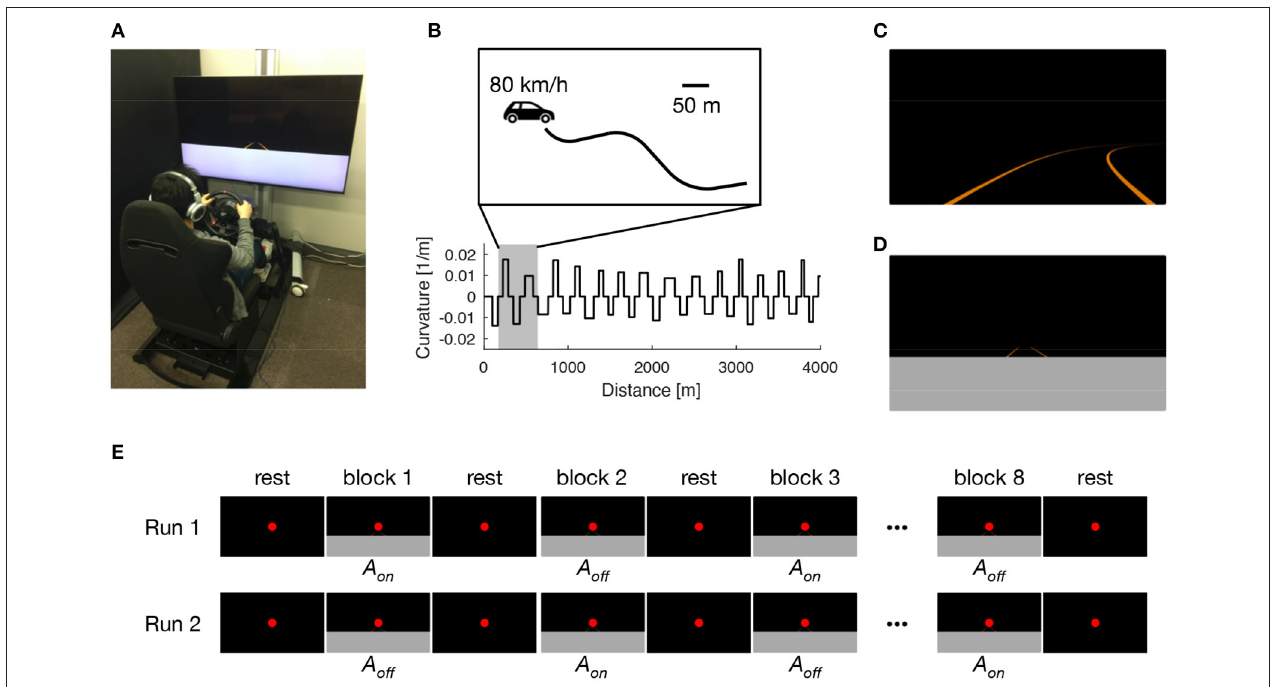
FIGURE 1 | Experimental setup. Participants performed 8 days of lane-keeping training on a custom-made driving simulator (A) . Driving courses consisted of a winding road that alternately curved leftward and rightward with a random curvature between 1/120 and 1/60 m − 1 , interleaved with straight sections with a constant length of 60 m (B) . Under normal driving (ND) condition, driving scenes were presented with auditory white noise with a constant loudness to both ears via headphones (C) . Under sensory augmentation (SA) condition, the lower part of the driving scene was occluded to restrict the visual cues needed for estimating vehicle lateral position, and information regarding vehicle lateral position was instead provided via binaural auditory stimuli (D) . The pretest and posttest MRI sessions comprised two block-design runs, in which participants were exposed to sensory stimuli that were relevant to the lane-keeping task under SA condition. In each run, driving scenes were presented alternately with ( A on ) and without ( A off ) auditory cues for vehicle lateral position (E) .